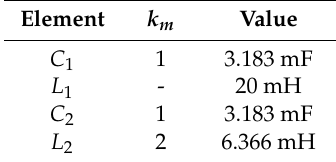
Table 2. Parameters value of filter